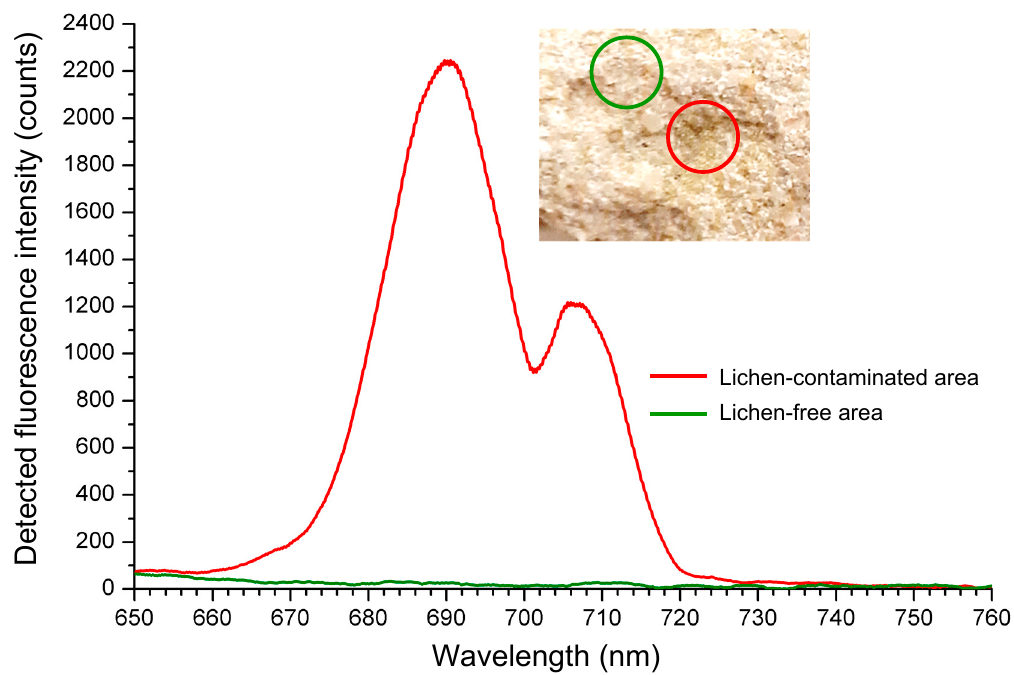
Figure 5. LIF spectra from the basilica wall, corresponding to emission from the lichen-contaminated (red) and lichen-free (green) areas.